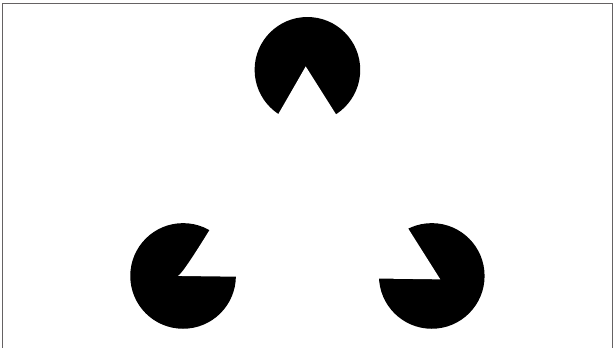
FigUre 2 | The Kanizsa triangle.